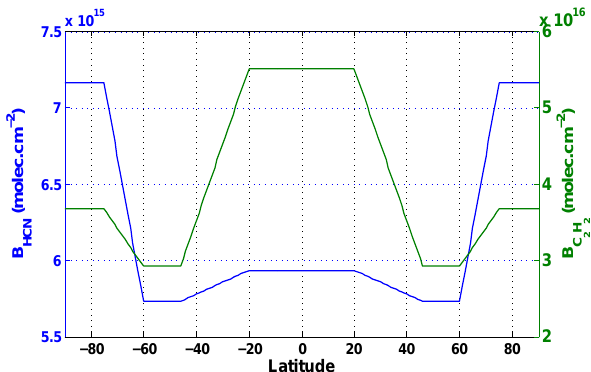
Figure 4. Values of B HCN (blue) and B C of the